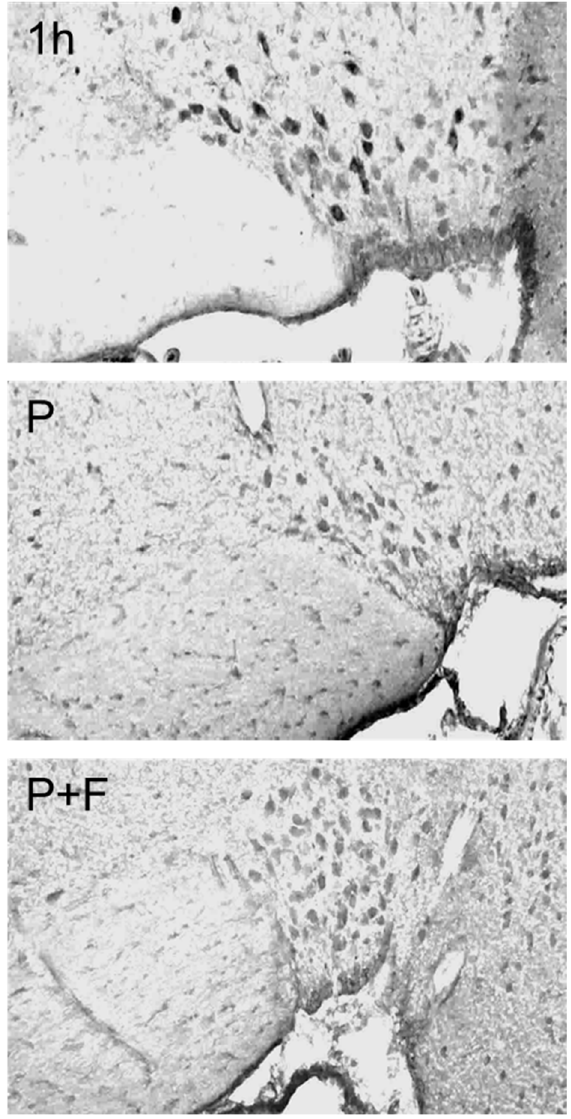
Figure A10. Oxytocin immunoreactivity in the supraoptic nucleus of Syrian hamsters. Comparison between 1 h manual sleep deprivation (1 h, group 3a), sexual stimulation with pheromone (P, group 2), and sexual stimulation with pheromone and females (P+F, group 1). Magnification: 80×.